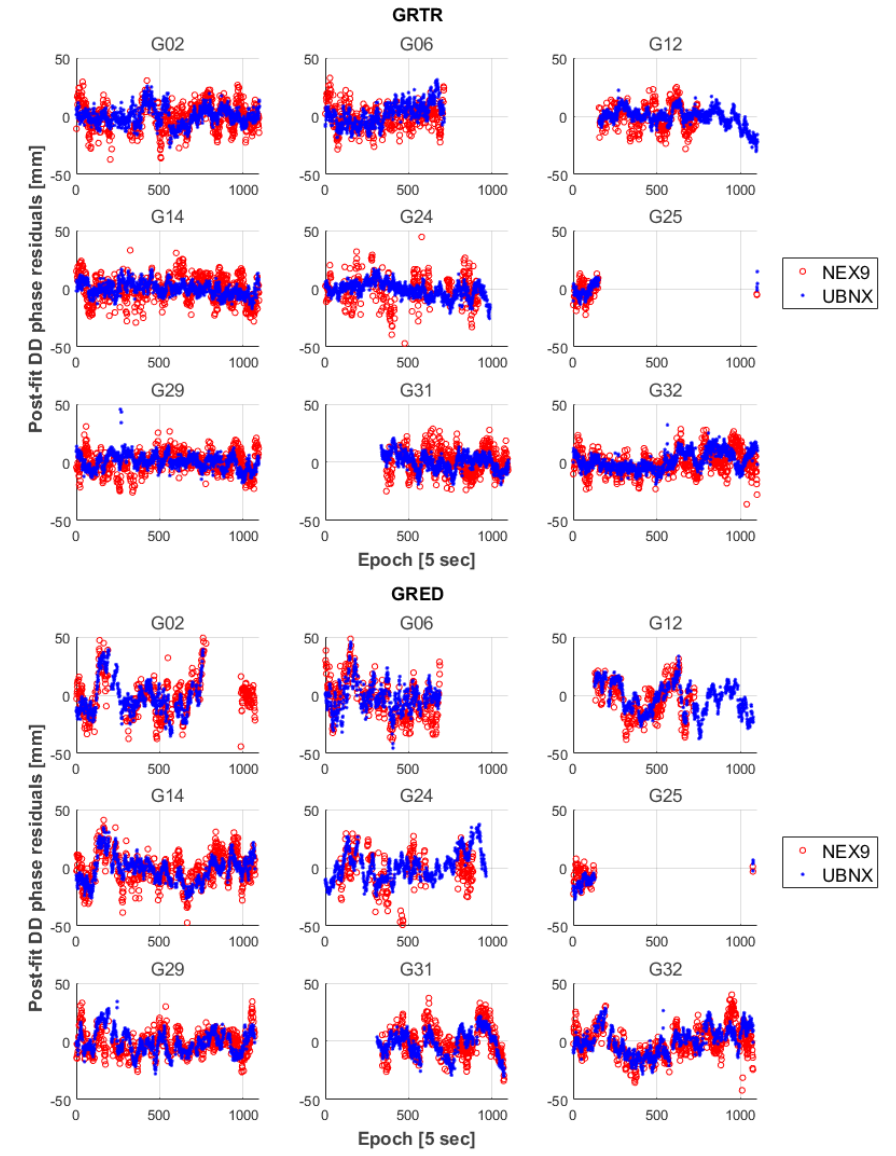
Figure 5. Post-fit double difference phase residuals of the float solutions for the baseline with respect to GRTR and GRED